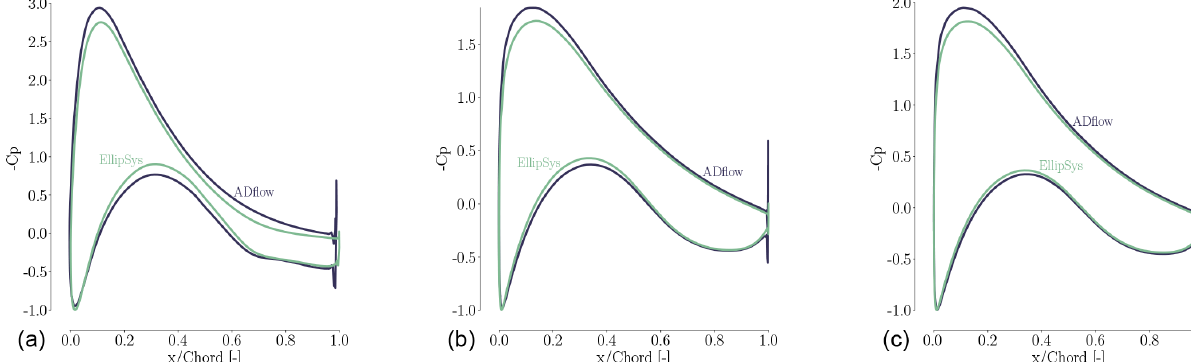
Figure A5. C p curves for 35m (a) , 64m (b) , and 84m (c) .